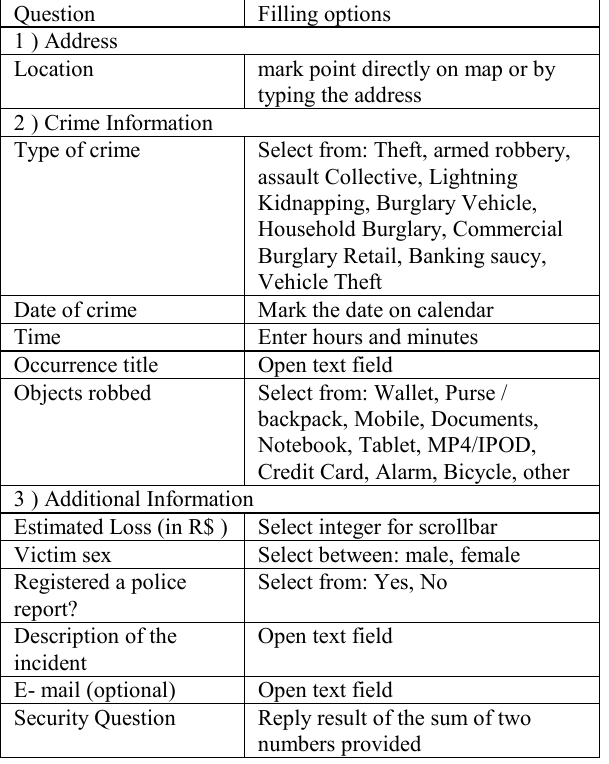
Table 1. Questions and options for filling registration form